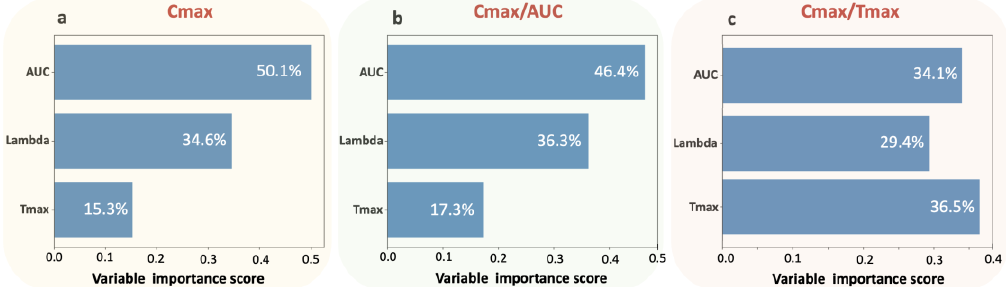
Figure 3. Variable importance scores for the feature parameters (AUC, lambda, Tmax) of the actual bioequivalence study. Three random forest models were developed each one referring to Cmax ( a ), Cmax/AUC ( b ), and Cmax/Tmax ( c ).